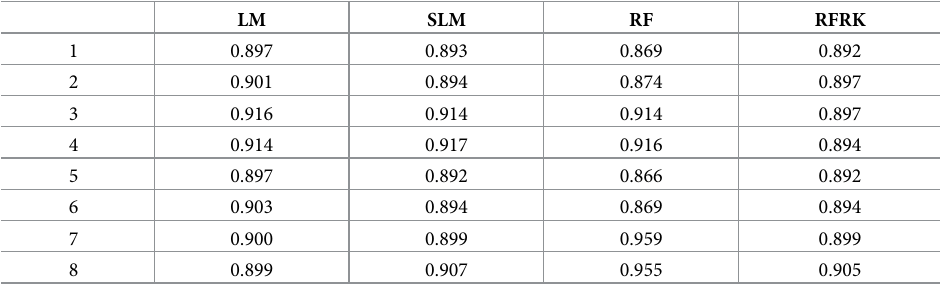
Table 4. Simulation results for coverage of 90% prediction intervals.